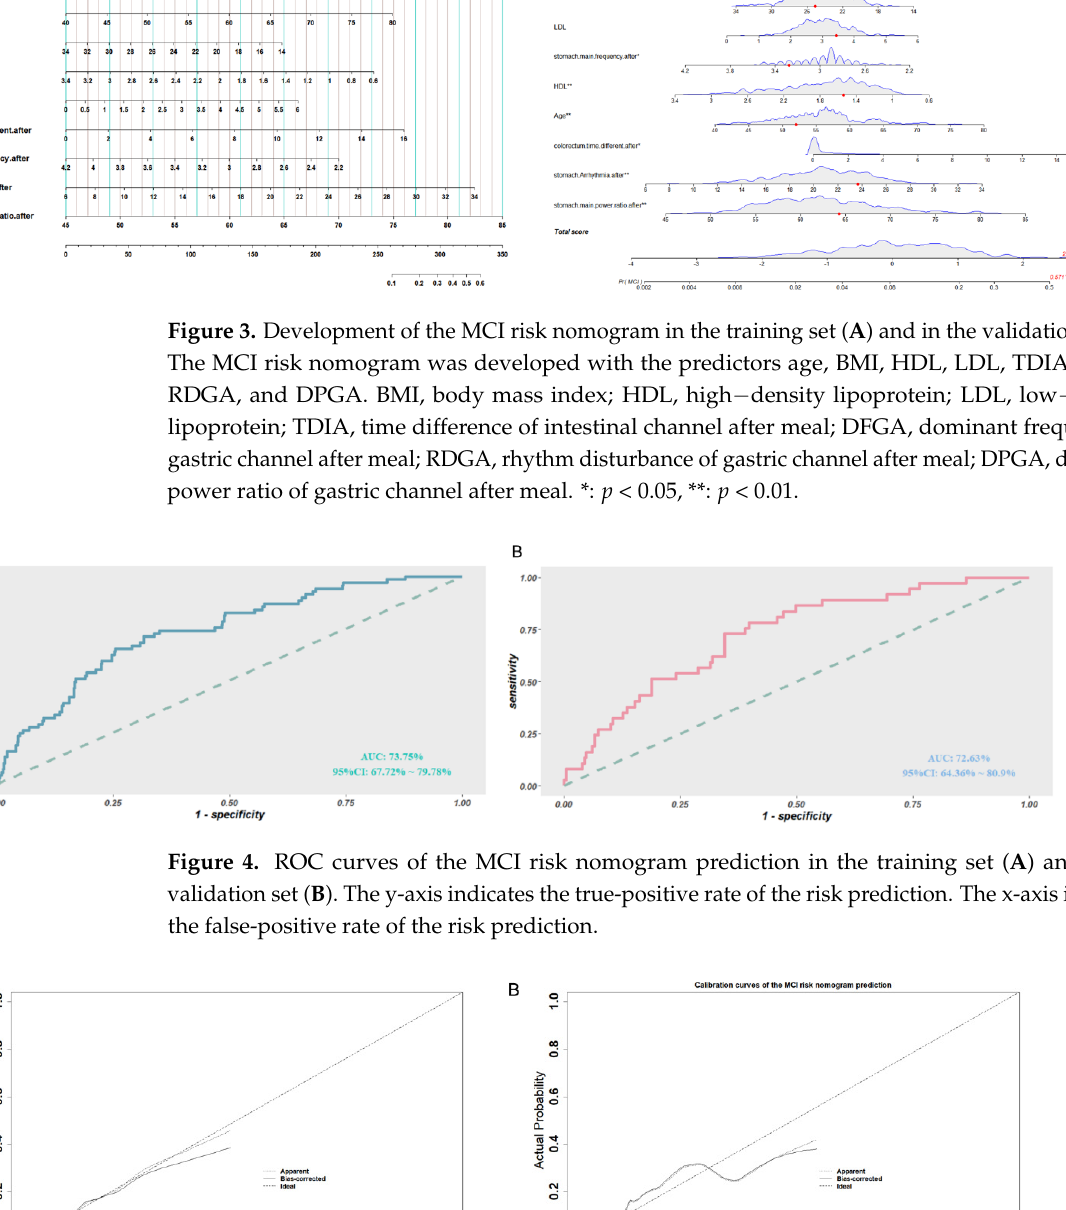
Figure 3. Development of the MCI risk nomogram in the training set ( A ) and in the validation set ( B ). The MCI risk nomogram was developed with the predictors age, BMI, HDL, LDL, TDIA, DFGA, RDGA, and DPGA. BMI, body mass index; HDL, high − density lipoprotein; LDL, low − density lipo ‐ protein; TDIA, time difference of intestinal channel after meal; DFGA, dominant frequency of gastric channel after meal; RDGA, rhythm disturbance of gastric channel after meal; DPGA, dominant power ratio of gastric channel after meal. *: P<0.05, **: P<0.01.